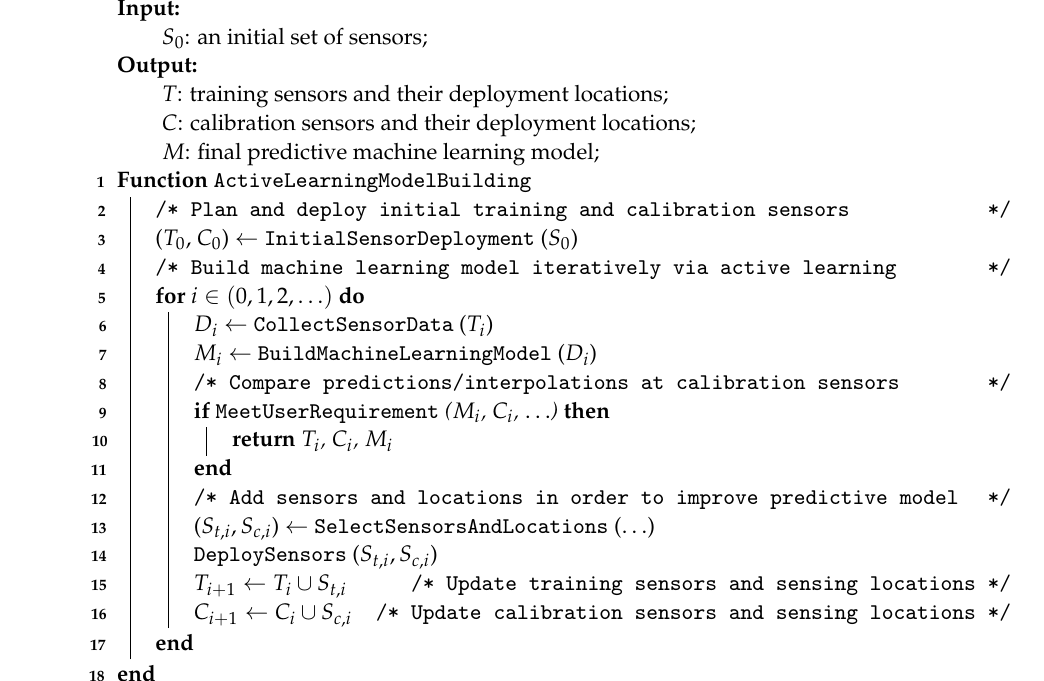
Algorithm 1: Active learning for building predictive